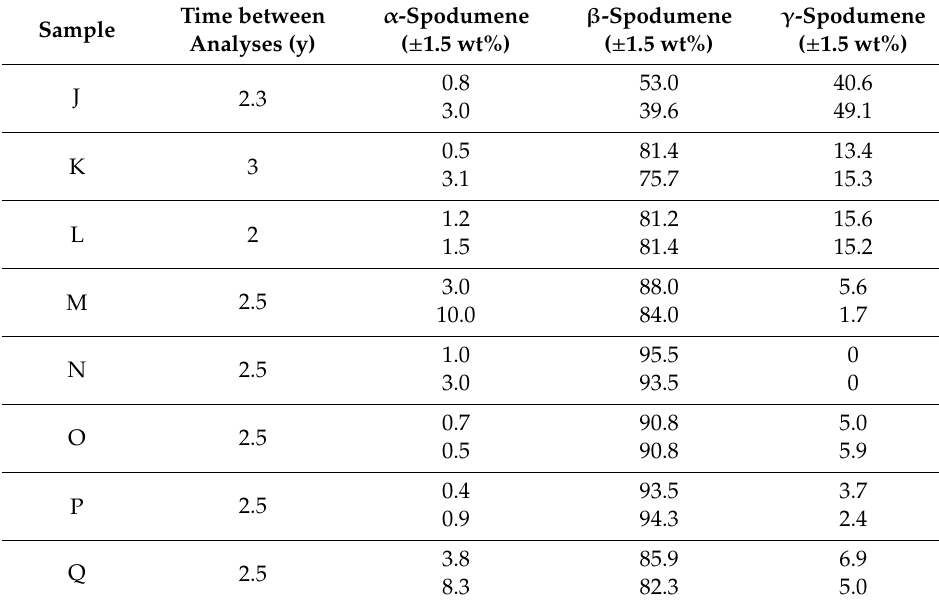
Figure 8. Ω variation over the aging period of samples J, K, L, M, N, O, P, Q.